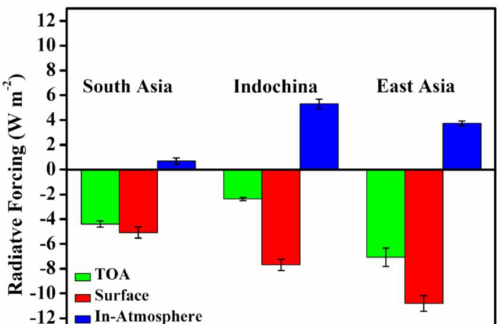
Figure 4. Anomalies of radiative forcing (Wm − 2 ) from ECHAM6– HAMMOZ simulations (BMaeroon − BMaerooff) at the TOA, sur- face, and in-atmosphere (TOA–surface) averaged for spring 2013 and over South Asia, Indochina, and East